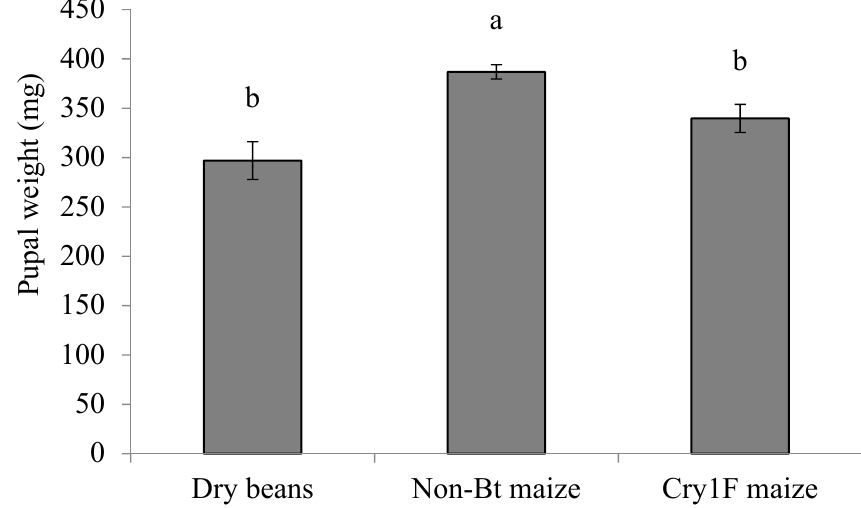
Figure 5. Pupal weight (mg ± SE) of S. albicosta larvae reared on dry beans, non- Bt maize, and Cry1F maize under controlled conditions. Different letters indicate significant differences between larval diets ( p < 0.05). Means comparison based on Tukey`s test.